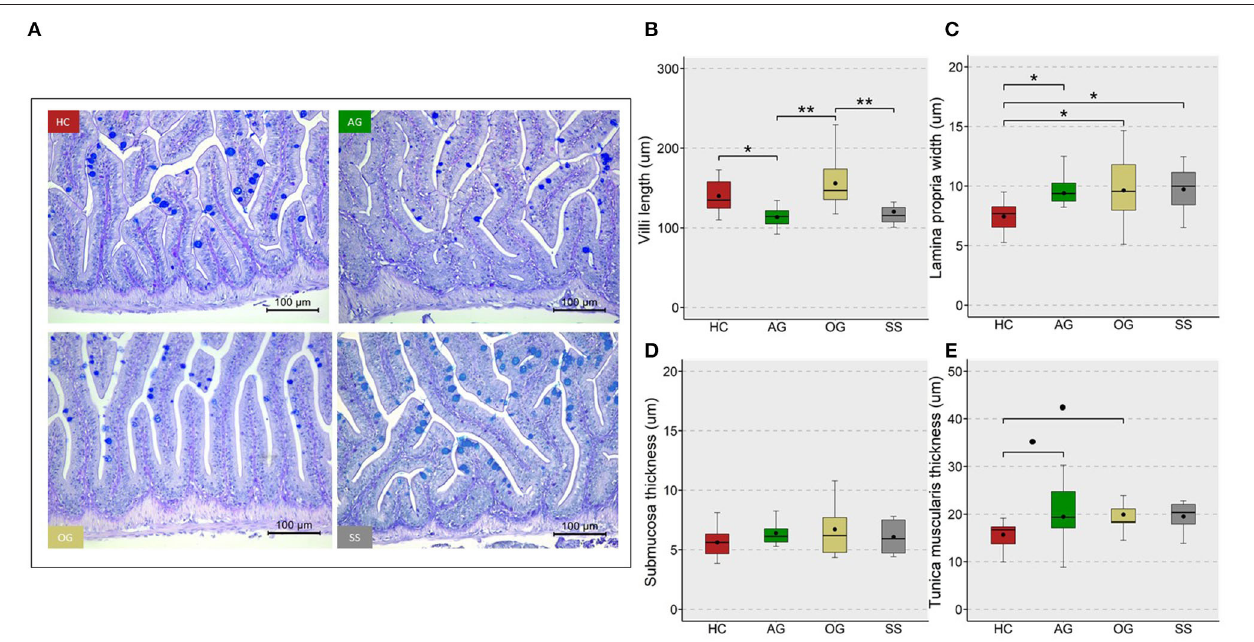
FIGURE 10 | Micromorphology and feature indices of the intestine of the zebrafish. Representative images (A) from the different study groups. Scale bar = 100 µ m. Boxplots show average villi length (B) , lamina propria width (C) , submucosa thickness (D) and tunica muscularis thickness (E) in the mid intestine of the fish fed experimental diets for a period of 12 weeks. Black dots inside each box indicate the mean values of the corresponding groups. ** indicates p < 0.01, * indicates p < 0.05, and • indicates p < 0.1. Each treatment group consisted of eight biological replicates.